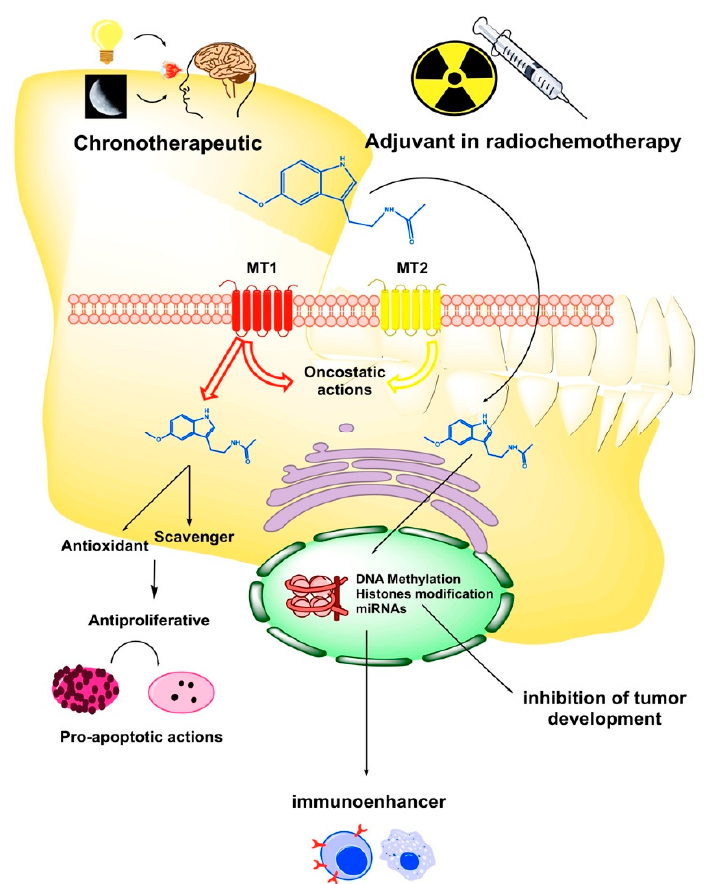
Figure 1. Schematic diagram of the critical points where melatonin may exert its protective and therapeutic effects on oral cancer (OC). MT1: melatonin receptor type 1; MT2: melatonin receptor type 2 .